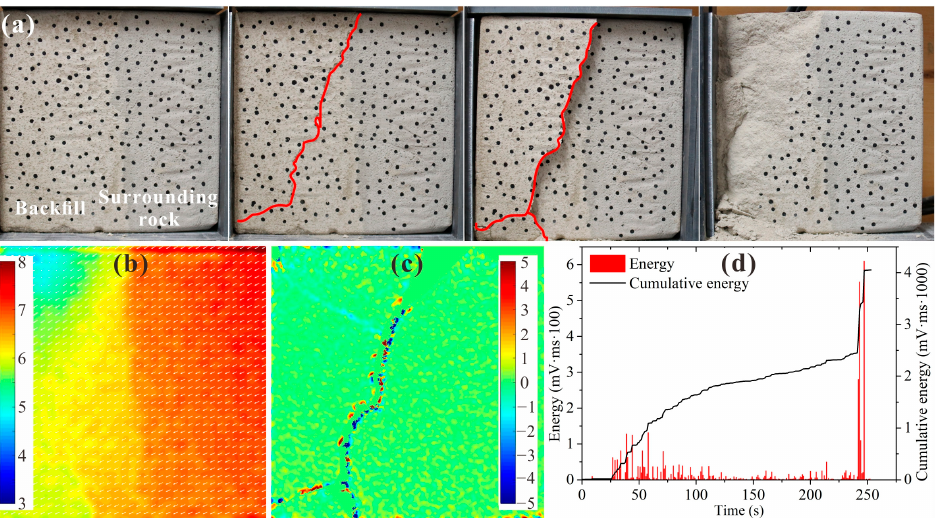
Figure 9. Experimental results for type A. ( a ) Damage and failure processes; ( b ) displacement field; ( c ) strain field; ( d ) acoustic emission energy.